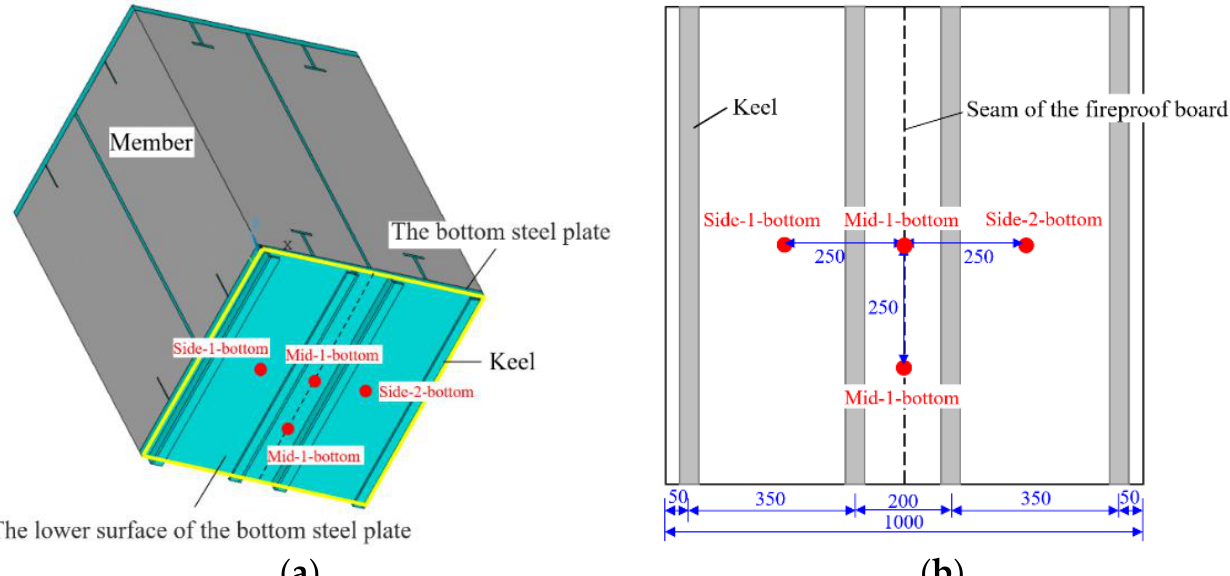
Figure 8. Distribution of thermocouples inside the member (unit: mm). ( a ) The horizontal position of the measuring points; ( b ) the longitudinal position of the measuring points.